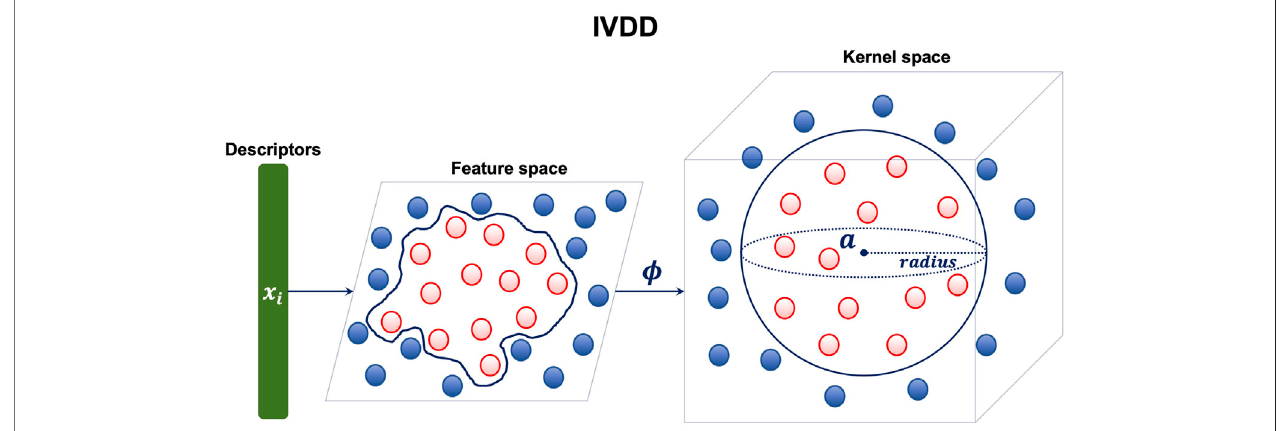
FIGURE 3 | IVDD method: each sample (druggable pocket) is a single point in a d -dimensional space (here d =35, which is the number of descriptors). The hypersphere is created in a kernel space. The mapping between the feature space and the kernel space is given by the function ϕ